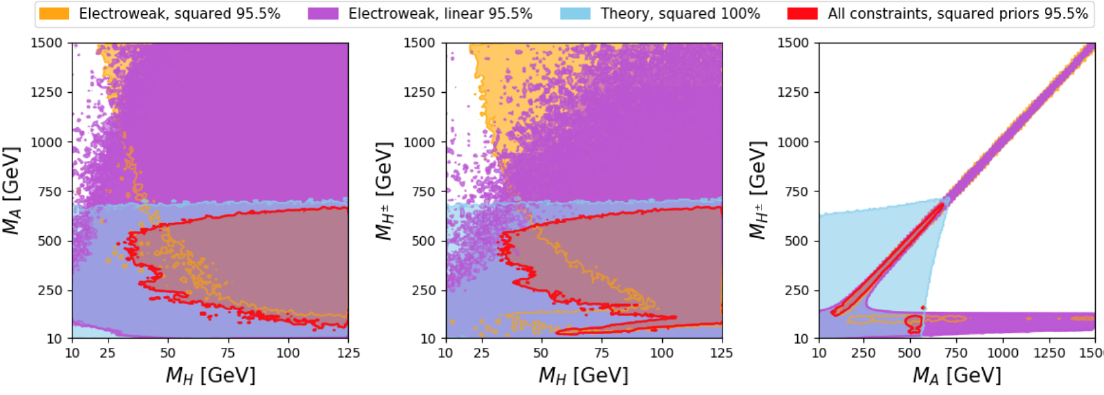
Figure 3. Allowed regions in the 2HDM, from a scan presented in